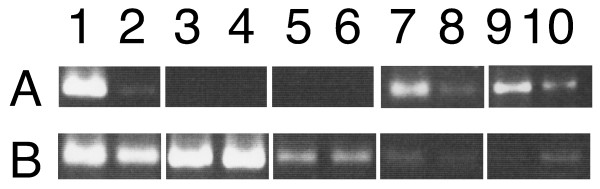
RT-PCR verification of genes detected by Affymetrix analysis but not by MPSS. All genes were determined to be expressed at 0 tpm by MPSS and detected present in C4-2 (A) or LNCaP (B) Affymetrix data. (A) Lane 1–2 UGT8, 3–4 FOXQ1, 5–6 ZNF533, 7–8 GALC, and 9–10 FLJ23259. (B) Lane 1–2 ZNF625, 3–4 TBRG4, 5–6 TRPV6, 7–8 SLC4A11, and 9–10 LOC286097. Odd lanes are C4-2 and even lanes are LNCaP cDNA. The expression of genes not detected by MPSS but detected by Affymetrix was verified with RT-PCR.